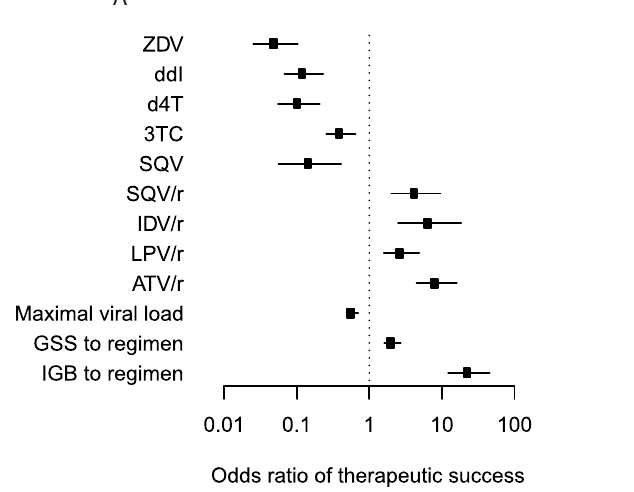
Figure 3. Multivariate analysis of predictors of response to antiretroviral combination therapy in the SHCS database. Associations have been tested using a logistic regression model and odds ratios of therapeutic success, defined as viral load reduction below 50 cps/ml (A) and 400 cps/ml (B), are reported together with their 95% confidence intervals on a logarithmic scale. Benjamini-Hochberg-corrected p-values are represented as black ( p v 0 : 001 ) and grey ( p v 0 : 01 ) symbols. Only predictors with a p-value smaller than 0.01 are included.